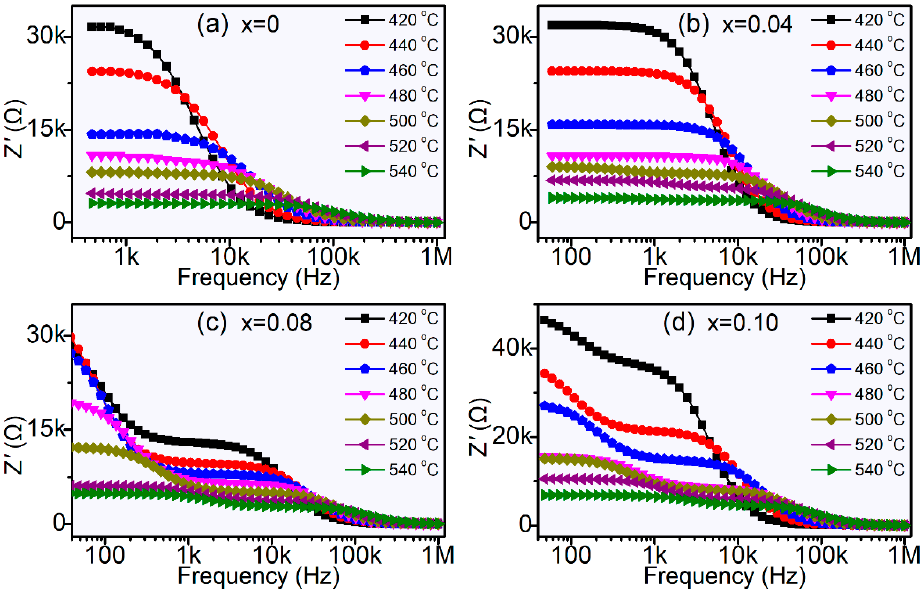
Figure 7. Frequency/temperature-dependent real parts of impedances for KNNS x -BNN ceramics with ( a ) x = 0, ( b ) x = 0.04, ( c ) x = 0.08 and ( d ) x = 0.10 measured at high temperature.